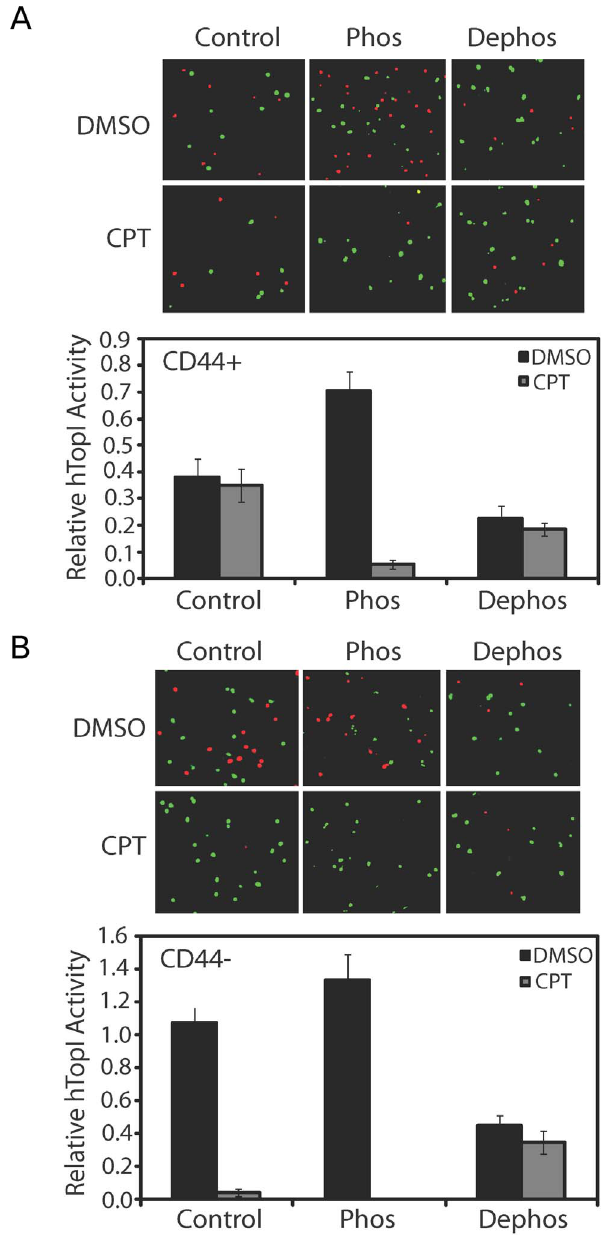
Figure 4. The effect of phosphorylation or dephosphorylation on the CPT sensitivity of TopI activity in extracts from FACS separated CD44 + cells or CD44 2 Caco2 cells. ( A ) The TopI activity in CD44 + cell extracts after phosphorylation or dephosphorylation. Whole cell extract was either left untreated (indicated by Control) or incubated with phosphatase (indicated by Dephos) or CK2 (indicated by Phos) before TopI activity was measured by REEAD in the presence of 60 m M CPT or 5% DMSO as indicated in the figure. One example randomly picked out of 12 individual microscopic images of each reaction sample is shown in the top panel. A quantitative depiction of three independent experiments, obtained as described in the legend of figure 1 is shown in the lower panel. ( B ) Same as ( A ), except that the analyses were performed on extracts from CD44 2 cells.